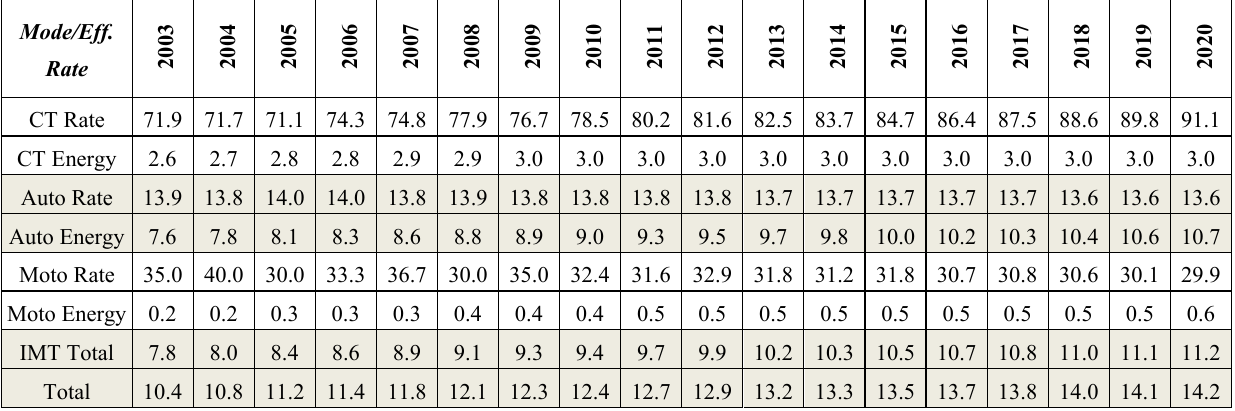
Table 7. Energy Consumption and Efficient Rate in Bi Pass-Km/Million TOE per Year. Mode/Eff.